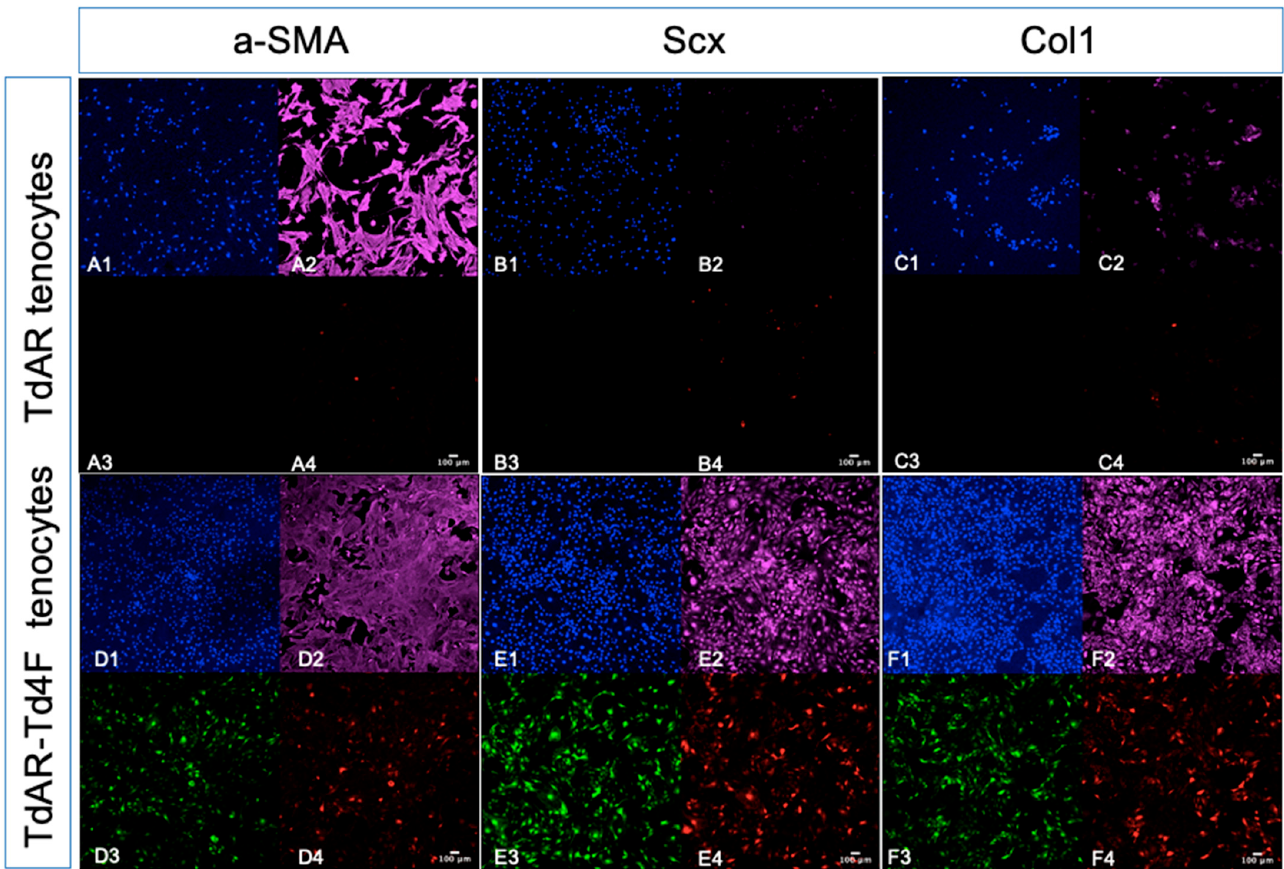
Figure 6. Overexpression of Td4F in tenocytes upregulated Scx and Col1a1 while reducing a-SMA expression. To further confirm the expression of Scx and Col1a1 and the fibrosis marker a-SMA in Scx+ primary Achilles tenocytes after induction of Td4F-EmGFP overexpression, we applied immunohistochemical staining (IHC) to tenocytes cultured for seven days using antibodies against Scx, Col1a1 and a-SMA. ( A – C ) show the results of staining for a-SMA, Scx and Col1a1 in primary Achilles tenocytes from TdAR mice under confocal microscopy ( × 10 magnification); 1 – 4 show the confocal DAPI staining ( A1 – F1 ), immunofluorescence staining ( A2 – F2 ), Td4F-EmGFP ( A3 – F3 ) and Scx-mScarlet ( A4 – F4 ) ( × 10 magnification). Focused microscope views. ( D – F ) show the results of staining for a-SMA, Scx and Col1a1 in primary Achilles tenocytes from TdAR-Td4F mice under confocal microscopy ( × 10 magnification). It can be seen that the expression of Scx-mScarlet was significantly higher in the case of the overexpression of Td4F. ( A2 , D2 ) Td4F overexpression reduced a-SMA expression in tenocytes, implying that Td4F has an antifibrotic potential. ( B2 , E2 ) Td4F overex- pression increased Scx expression in tenocytes, implying that Td4F expression maintained tenocyte identity. ( C2 , F2 ) Td4F overexpression increased Col1a1 expression in tendon cells, suggesting that Td4F expression could promote tendon recovery after